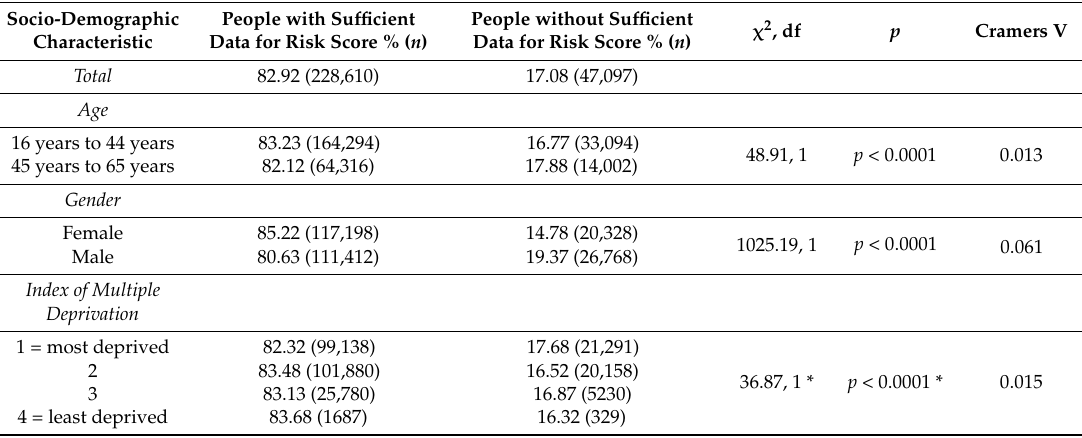
Table 3. Comparison of socio-demographic characteristics for individuals for whom a risk score could be calculated compared with individuals for whom a risk score could not be calculated. Socio-Demographic People with Sufficient Characteristic Data for Risk Score % ( n